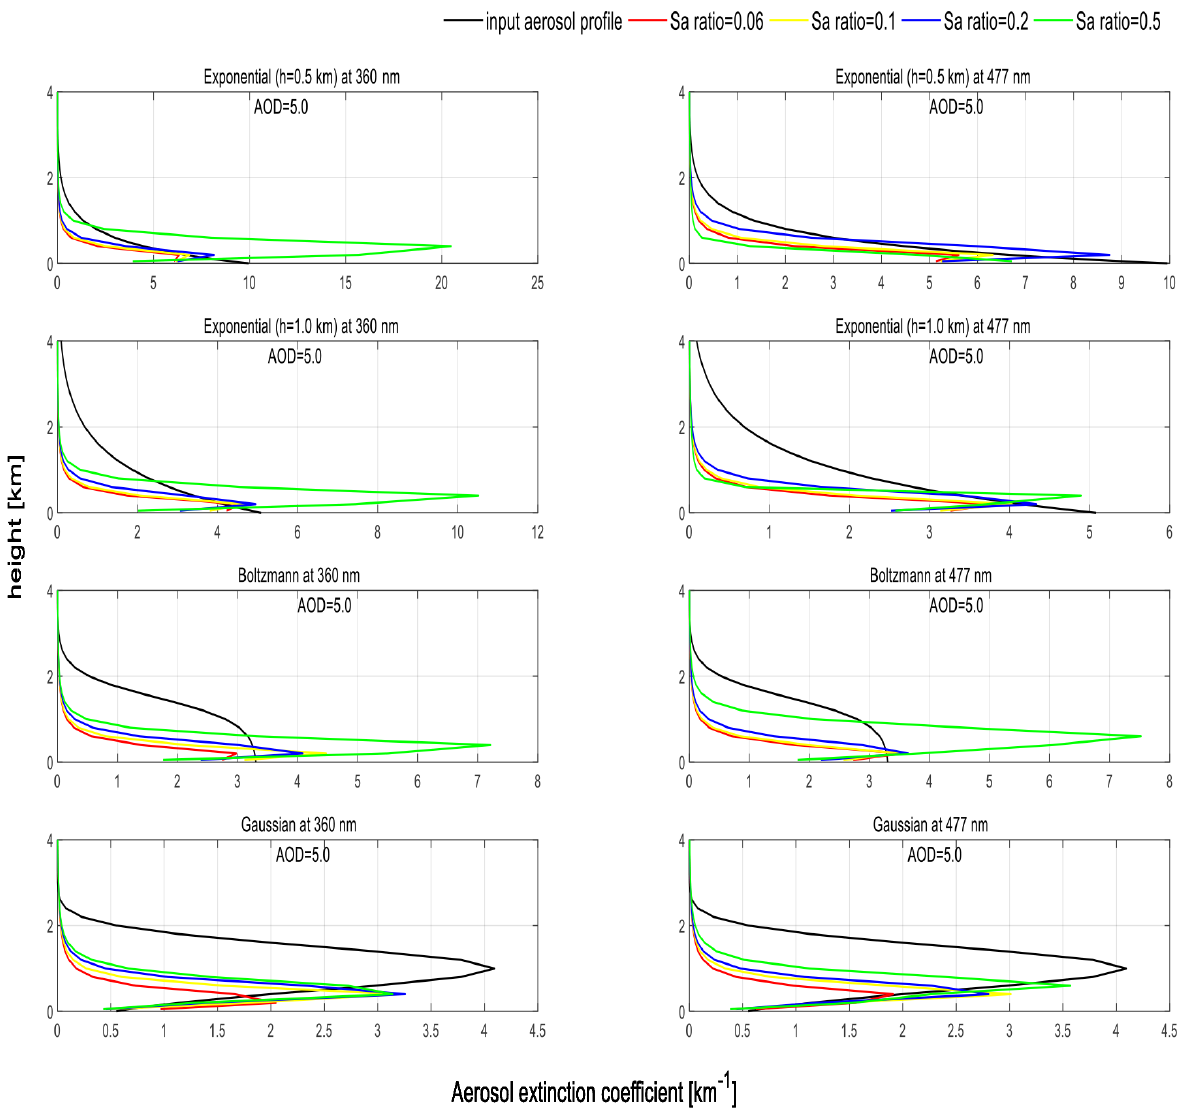
Figure 6. Results for three aerosol profile shapes retrieved by PriAM for an AOD of 5.0 using different values of the a priori profile covariance matrix ( S a